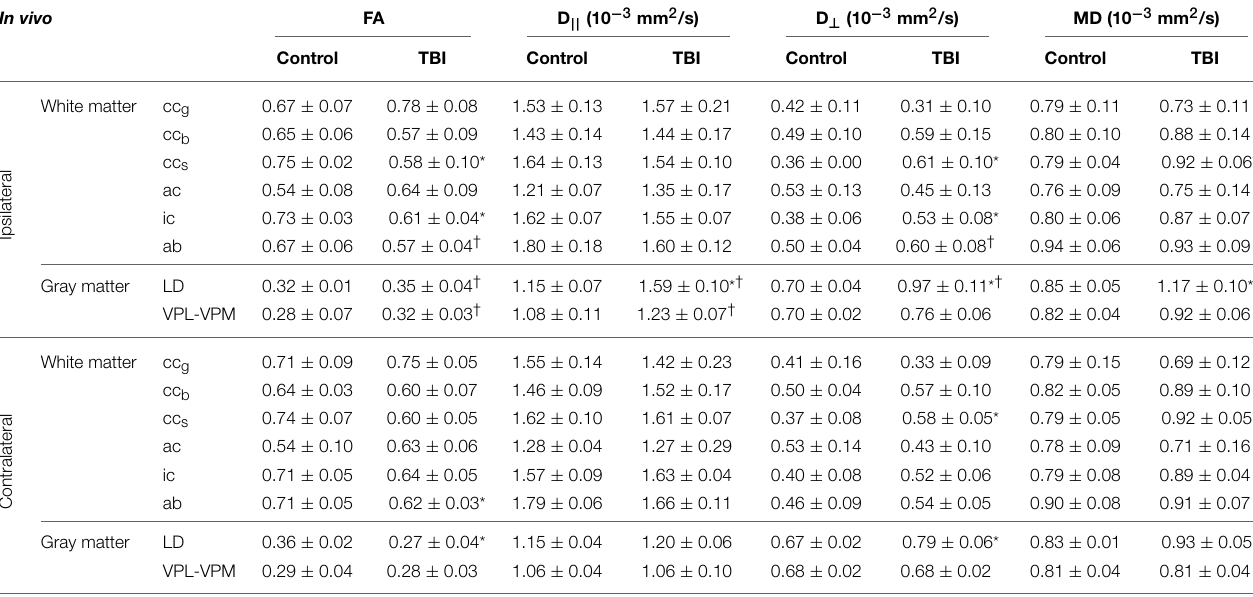
TABLE 3 | Fractional anisotropy (FA), and axial (D || ), radial (D ⊥ ), and mean (MD) diffusivities from ipsilateral and contralateral hemispheres in controls ( n = 7 ) and rats after TBI ( n = 8 ) obtained using in vivo DTI. In vivo